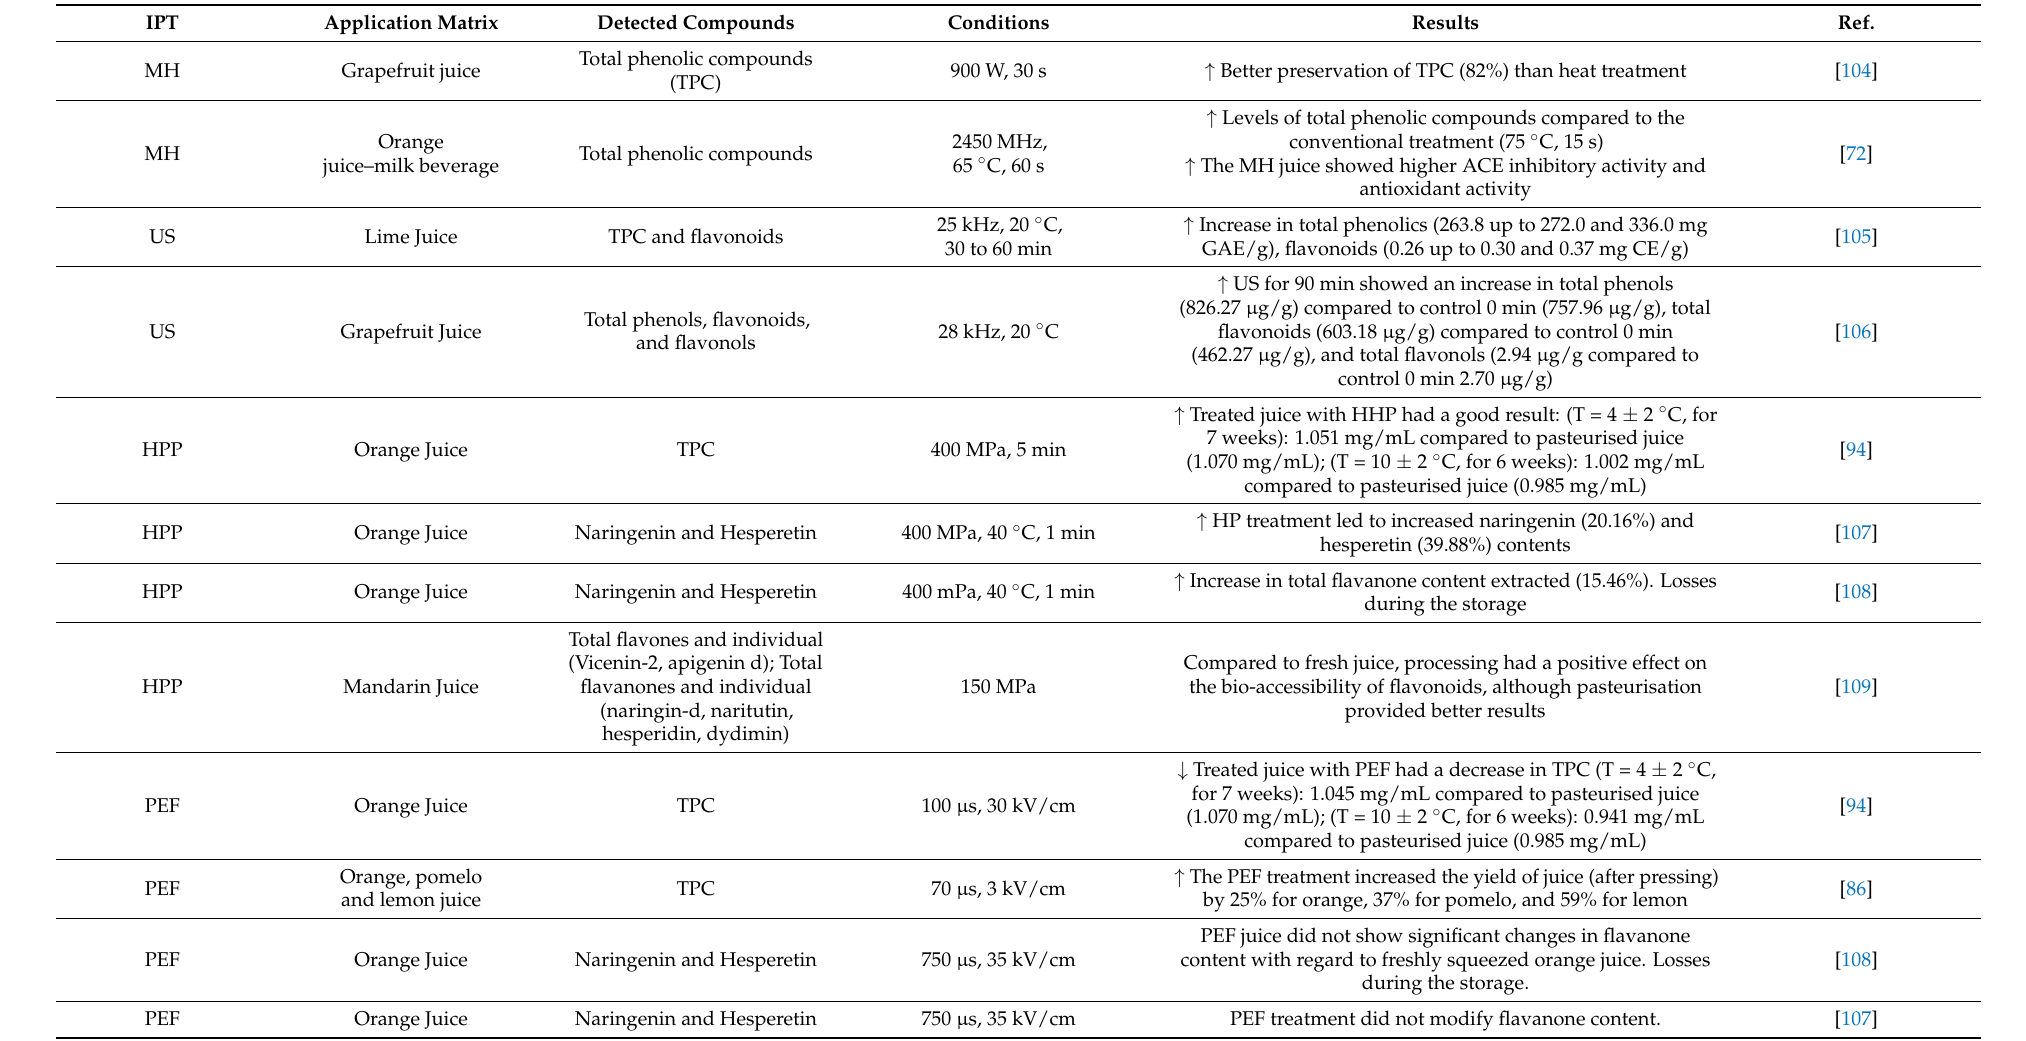
Table 3. Impacts of innovative processing technologies on citrus juice phenolic